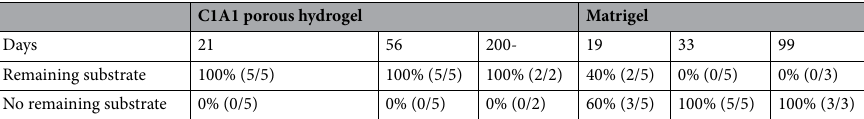
Table 3. Remaining rate of each implanted substrates.